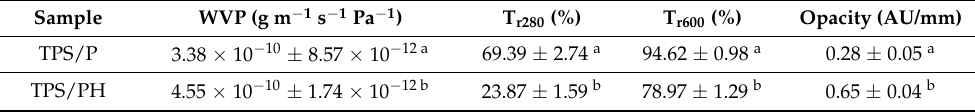
Table 3. Water vapor permeability (WVP) (g m − 1 s − 1 Pa − 1 ), light transmittance (%), and transparency value of the prepared